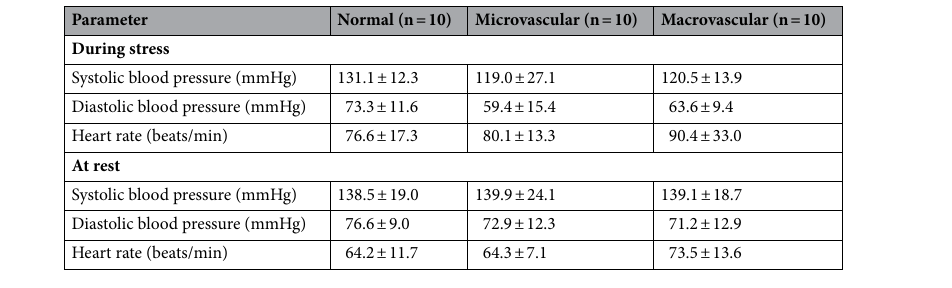
Table 2. Hemodynamic response to